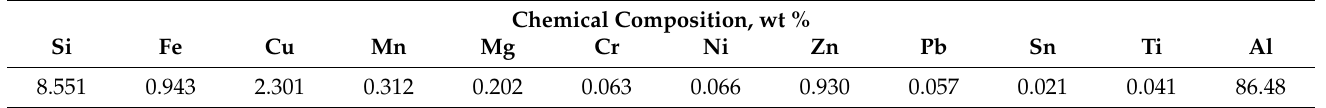
Table 1. Average chemical composition of AlSi9Cu3(Fe) alloy samples taken during operational tests. Chemical Composition, wt %